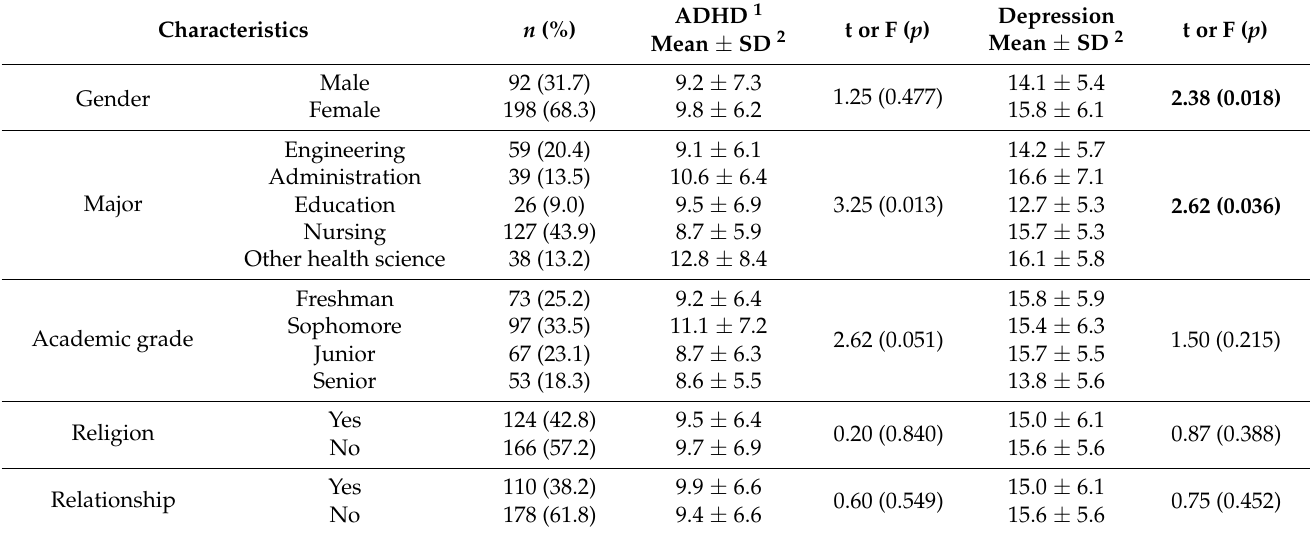
Table 1. Attention-Deficit Hyperactivity Disorder and depression scores by subgroups of general characteristics. ( n =